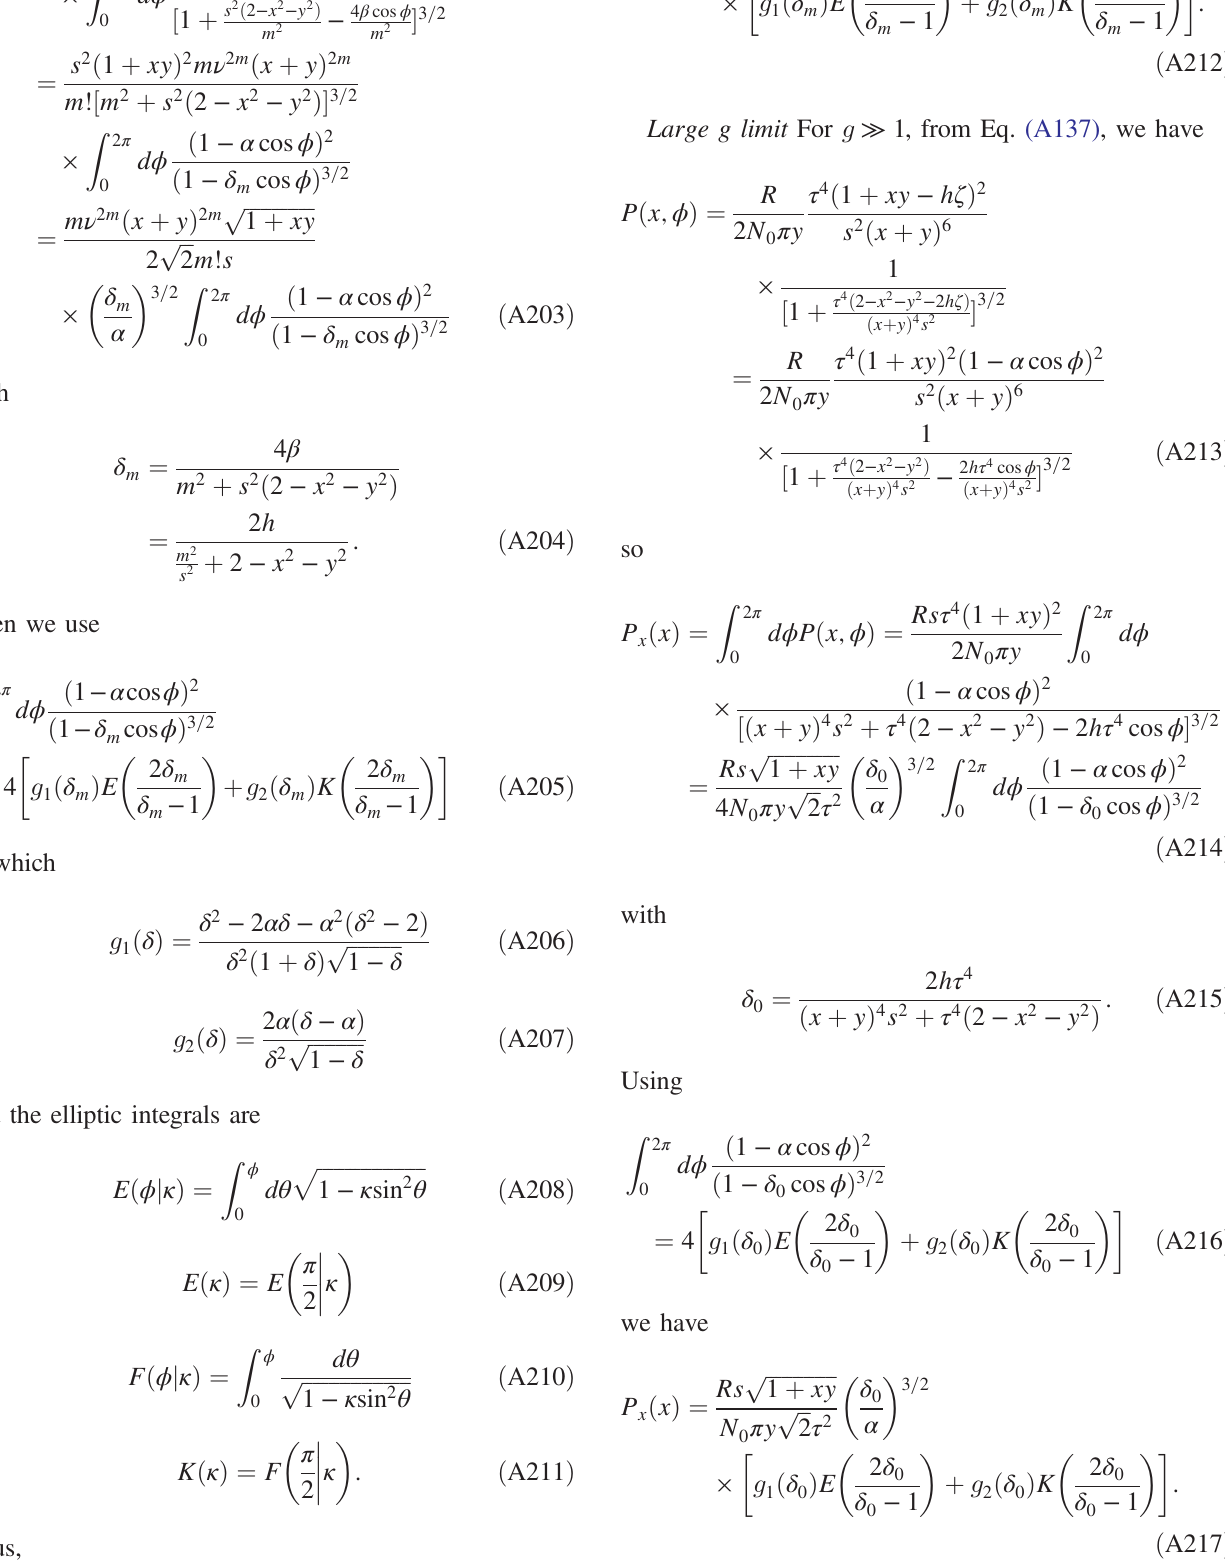
ffiffiffiffiffiffiffiffiffiffiffiffiffi 1 þ xy